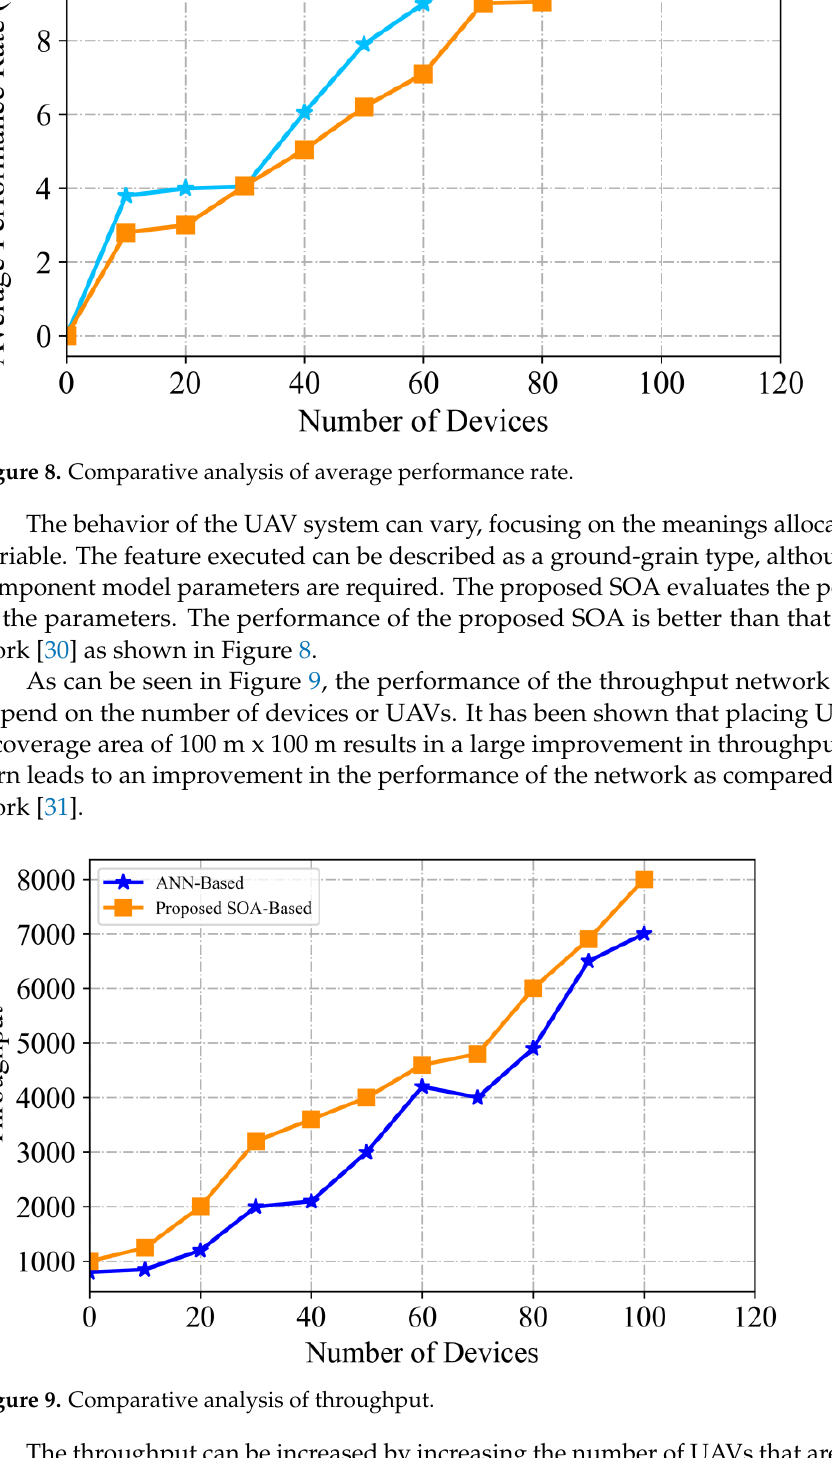
Figure 10. Comparative analysis of delay. The impact of path loss propagation on UAV and rescue center performance is an- other important consideration. Due to the higher route loss and lower transmitting power of the rescue center, interference caused by the rescue center to the UAV is negligible if the distance between the rescue and UAV is greater than the UAV coverage. Figure 11 shows, for instance, how the route loss grows as UAVs are moved various distances. In the proposed SOA, the path loss is from 32 dB to 59 dB at 1000 m while in the existing method [31] the path loss is reported to be from 44 dB to 69 dB, which is higher.